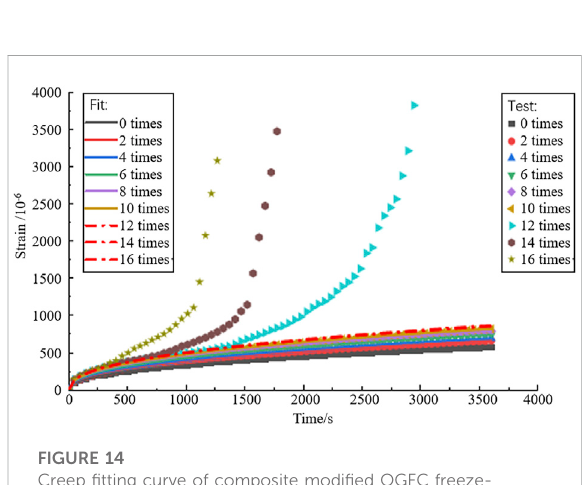
FIGURE 14 Creep fi tting curve of composite modi fi ed OGFC freeze- thaw damage at mixing ratios of